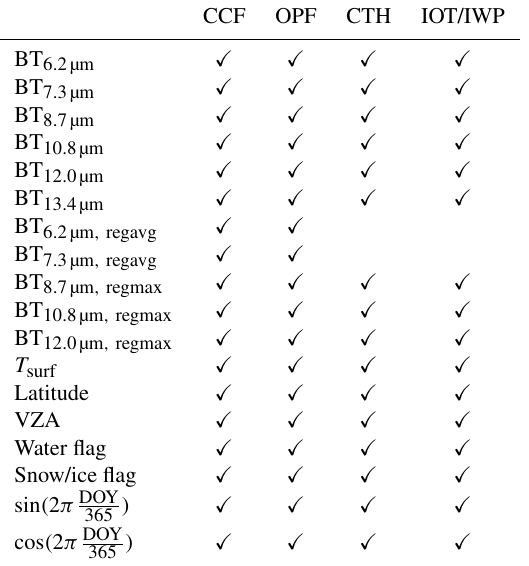
Table 2. Input data used to train the four ANNs contained in CiPS. BT is brightness temperature, regavg is regional average, regmax is regional maximum and VZA is the viewing zenith